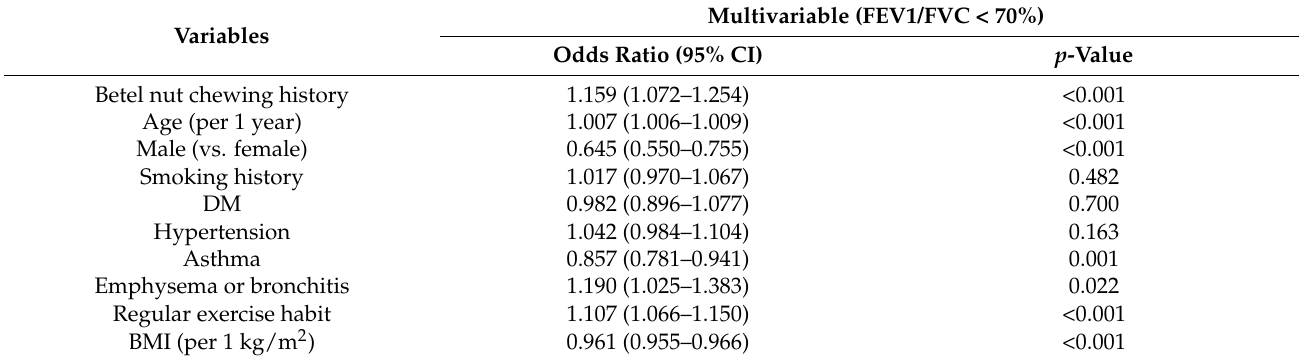
Table 2. Association of betel nut chewing history with FEV1/FVC < 70% in all study participants ( n = 80,877) using multivariable logistic regression